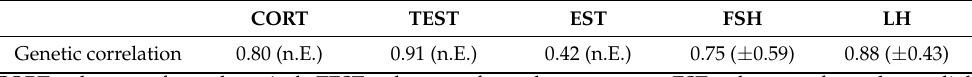
Table 4. Genetic correlation ( ± SE) between male and female hormone